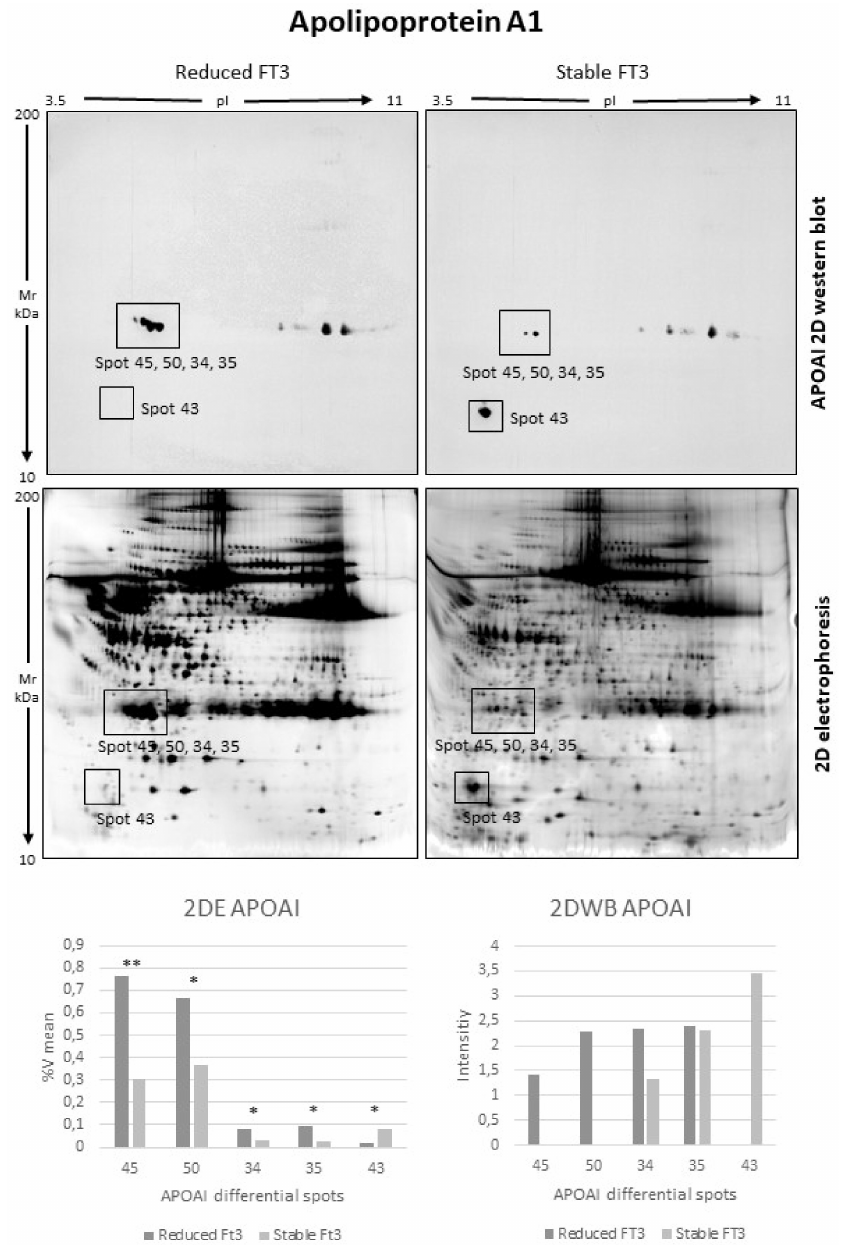
Figure 3. Two-dimensional western blot (2DWB) analysis of apolipoprotein AI (APOAI) (* = p -value < 0.05; ** = p -value < 0.01) (2DWBs reported in figure are the entire WB membrane images). Squares on the images highlight the areas where spots 45, 50, 34, 35, and 43 are